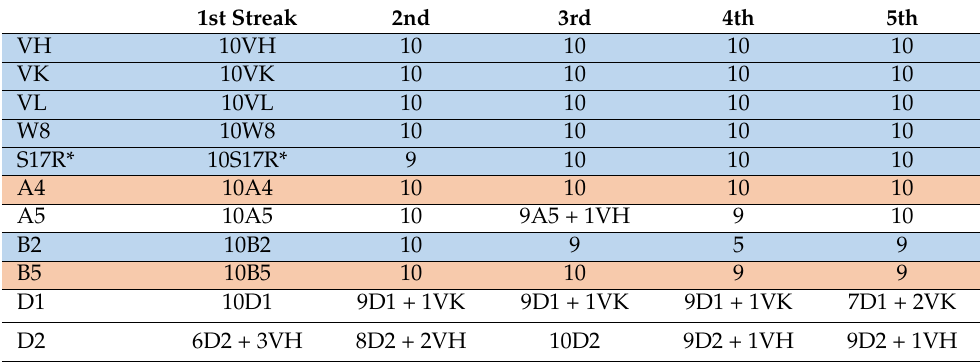
Table 4. Serial propagation with excess